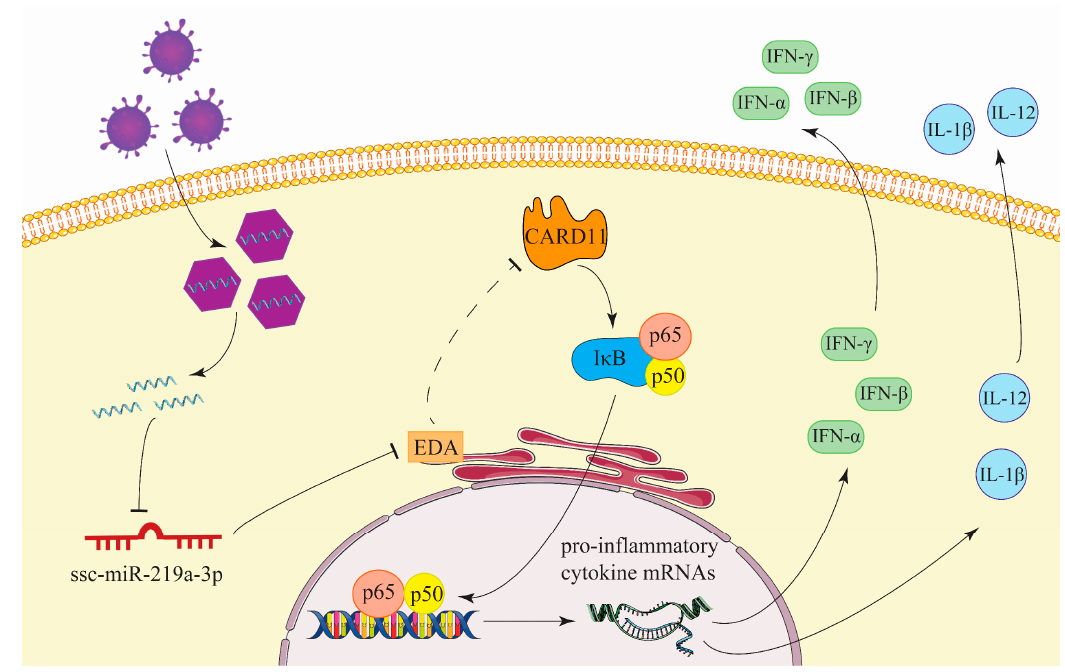
Figure 6. miR-129a-3p inhibits PEDV replication by targeting the EDA-mediated NF- κ B pathway in IPEC-J2 cells. Ligand ectodysplasin, EDA; Caspase activation and recruitment domain 11, CARD11; NF- κ B I κ B, I κ B; NF- κ B p65, p65; NF- κ B p50, p50; Interferon-alpha, IFN- α ; Interferon-beta, IFN- β ; Interferon-gamma, IFN- γ ; Interleukin-12, IL-12; Interleukin-1beta, IL-1 β .